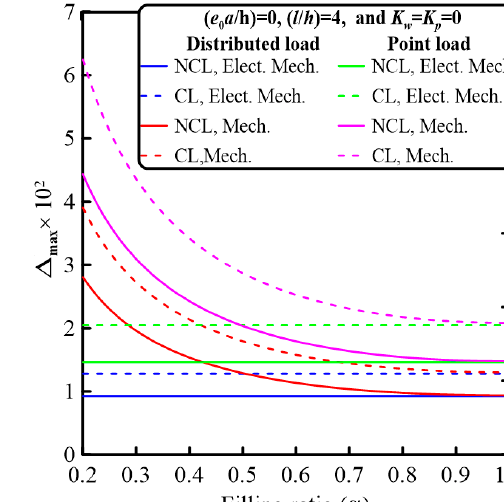
due to increas- α